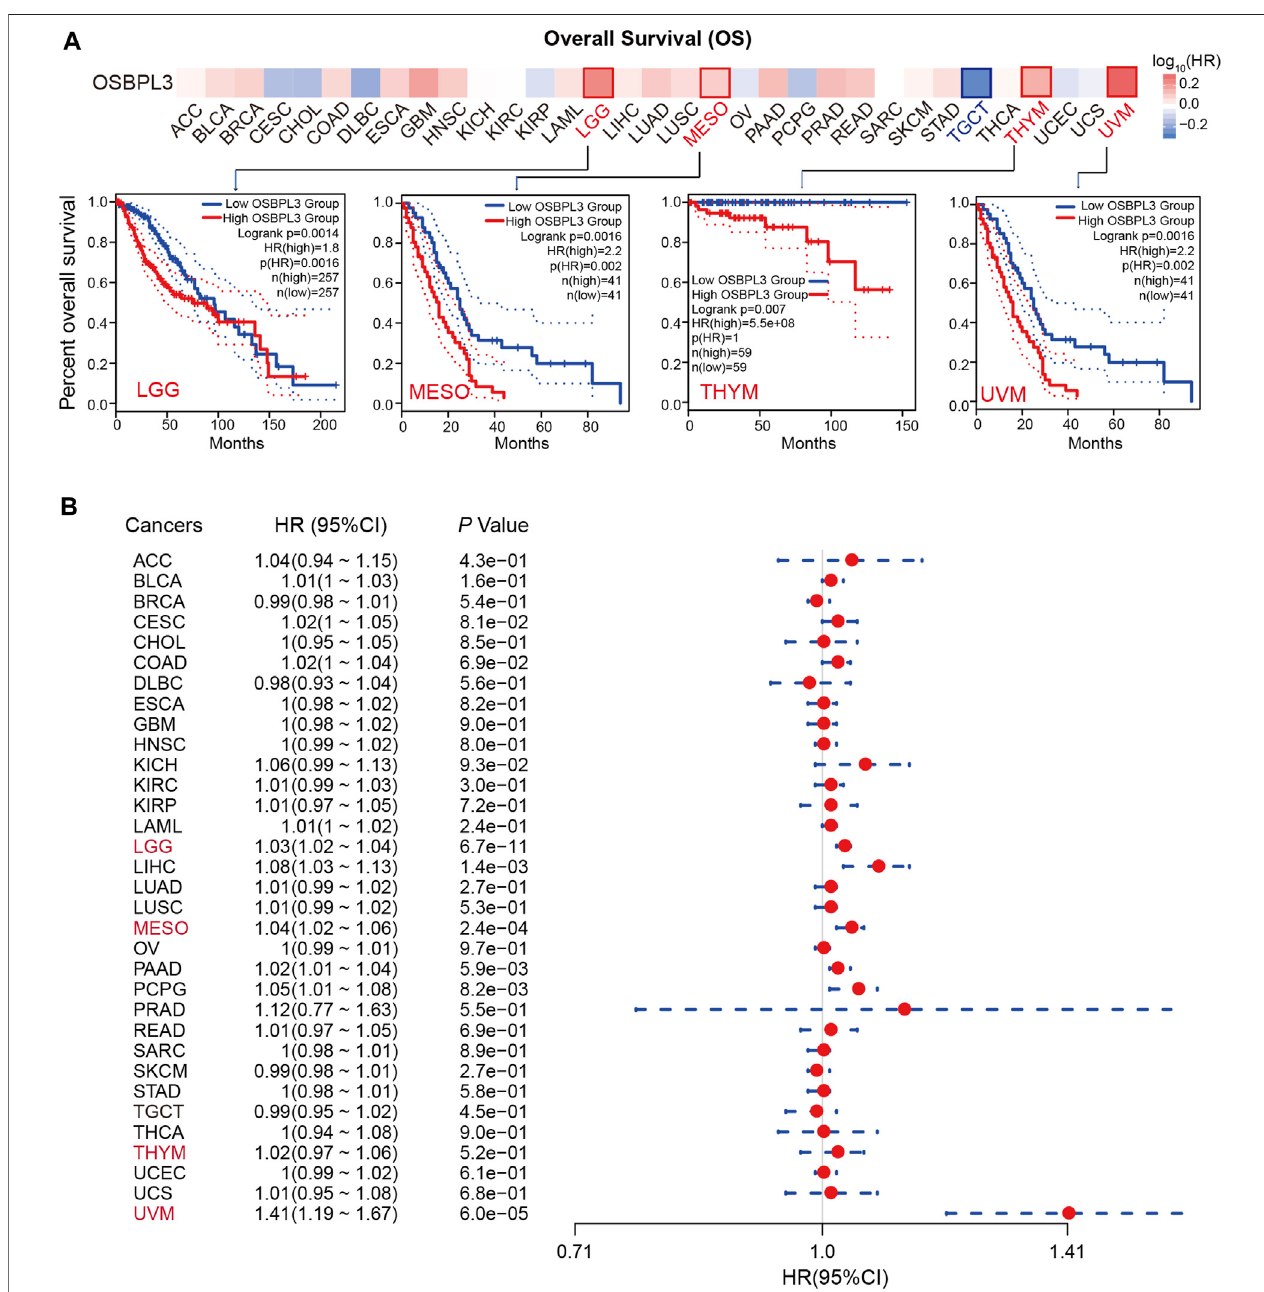
FIGURE 3 | Correlation between OSBPL3 expression and overall survival prognosis of different cancers. (A) Overall survival (OS) analyses of OSBPL3 gene expression acrossdifferenttumorsinTCGA viatheGEPIA2dataset. Up:survivalmap; down:Kaplan – Meierplottercurves. (B) Ameta-analysis(forest plot)forpoolingof a series of univariate overall survival of OSBPL3 expression in different tumors. Hazard ratios (HRs), 95% con fi dence intervals (95% CIs), and p -values are shown.